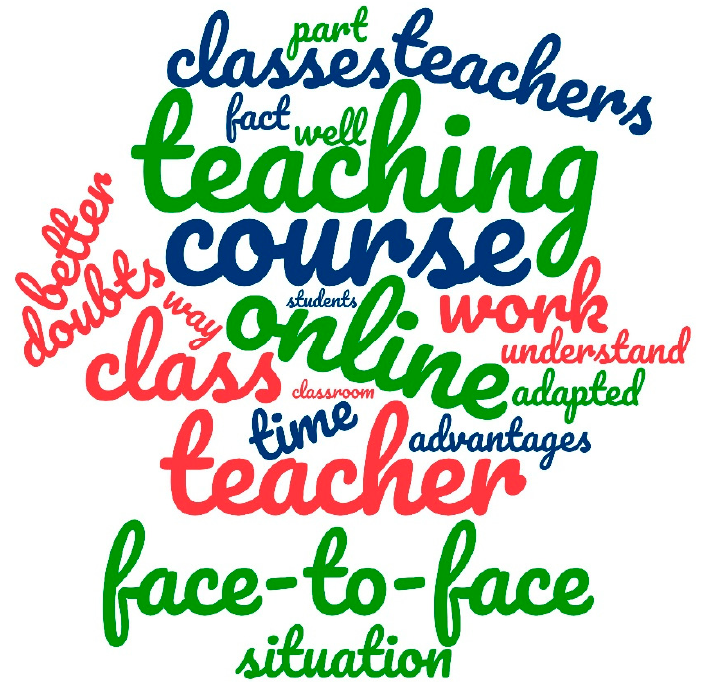
Figure 8. Word cloud of student responses to question 21.